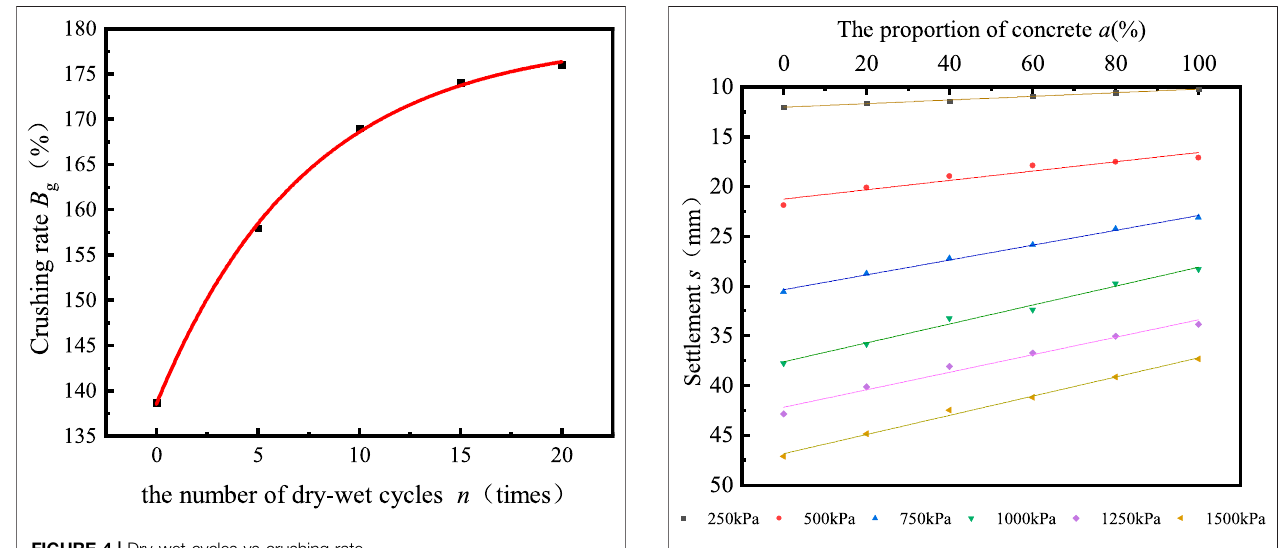
FIGURE 6 | The proportion of concrete vs settlement.